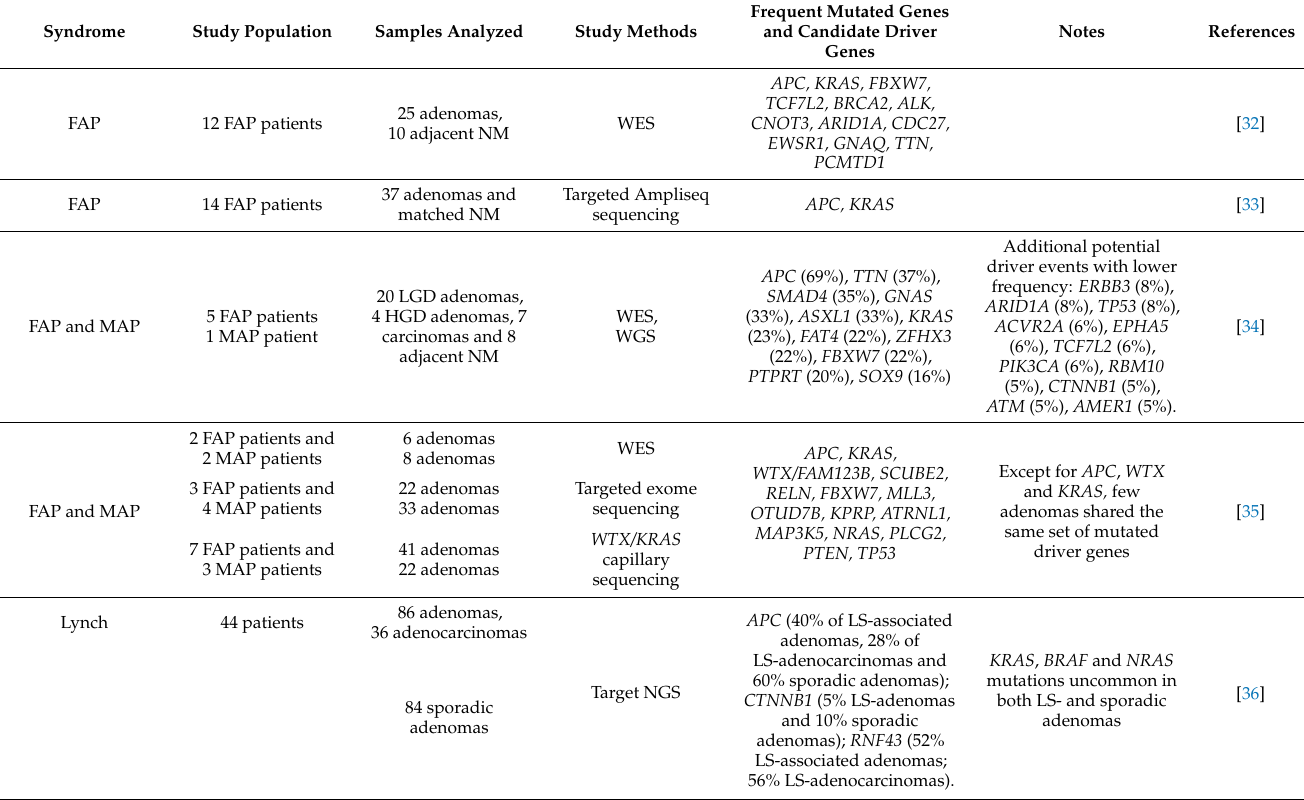
Table 1. Studies evaluating somatic mutations in colorectal adenomas and cancers from patients with hereditary CRC